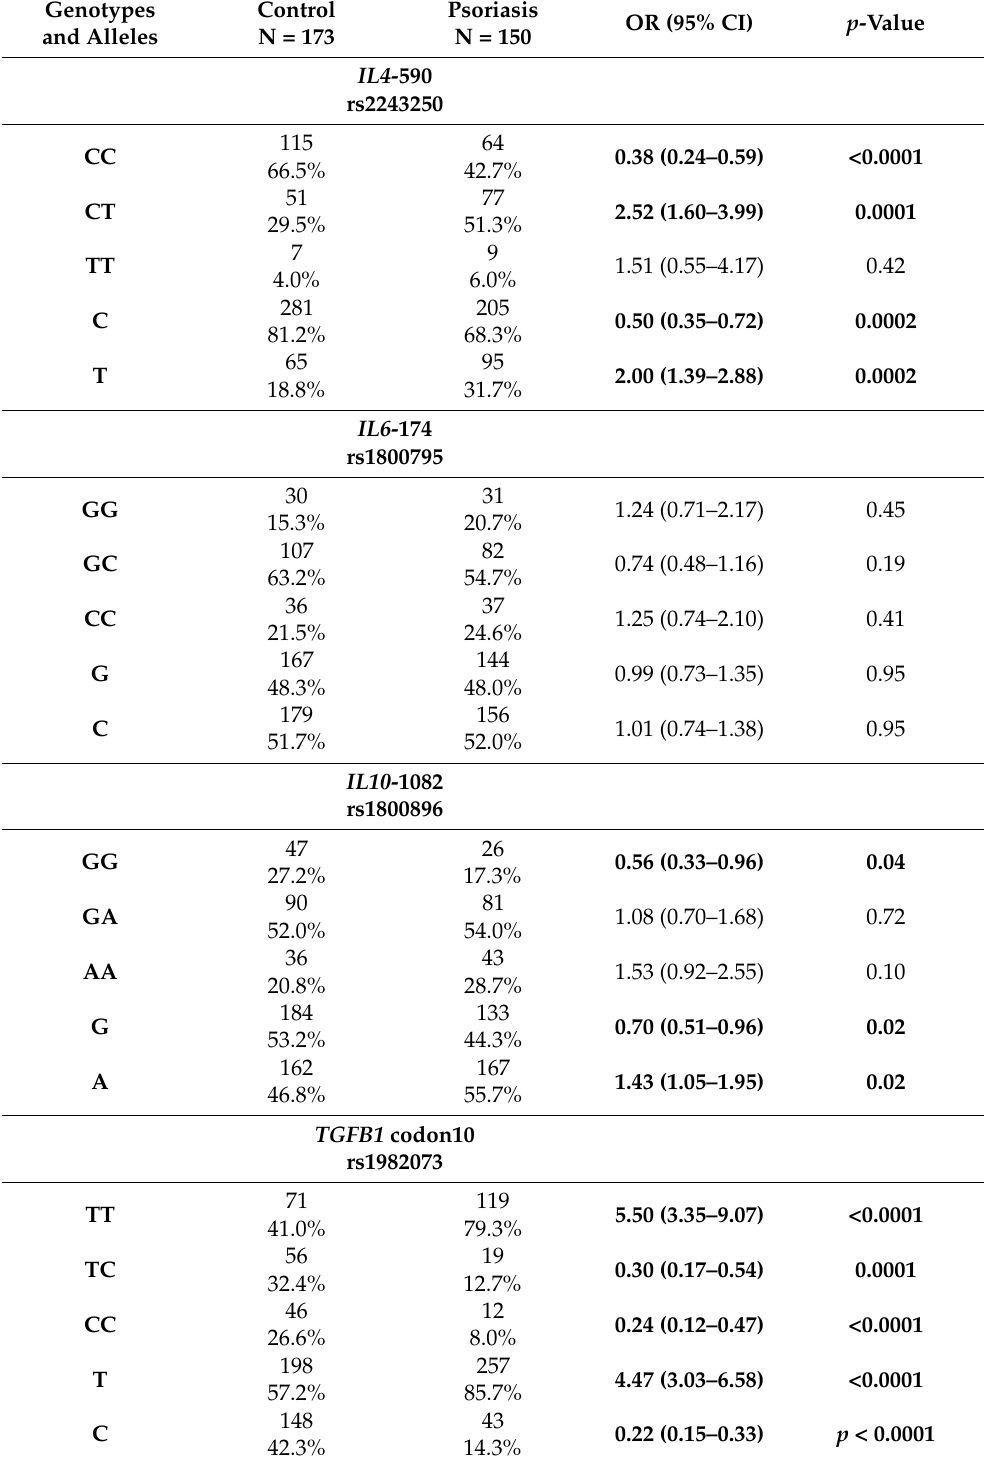
Table 4. The occurrence of genotypes and alleles for selected gene polymorphisms in PsO patients and the control group.